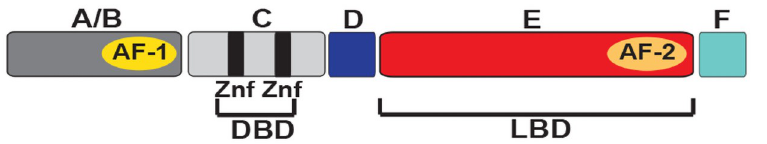
Fig 1. Schematic of conserved domain architecture of Nr2f TFs. A/B (N-terminal variable domain with transactivating AF-1 domain), C (DBD, which contains two Zinc finger (Znf) motifs), D (a linker domain), E (LBD plus transactivating AF-2 domain), and F